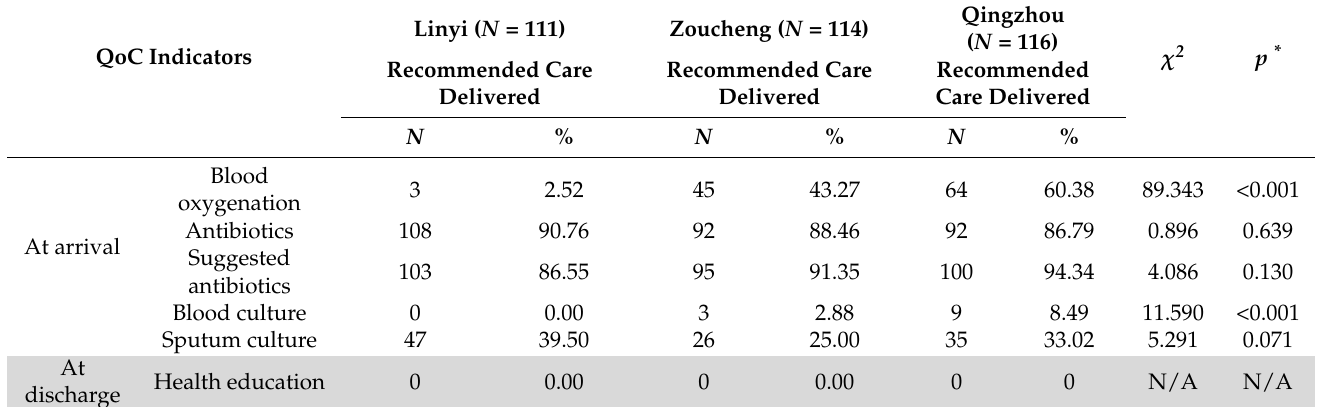
Table 7. Level of QoC for pneumonia in 3 selected counties ( N = 329).